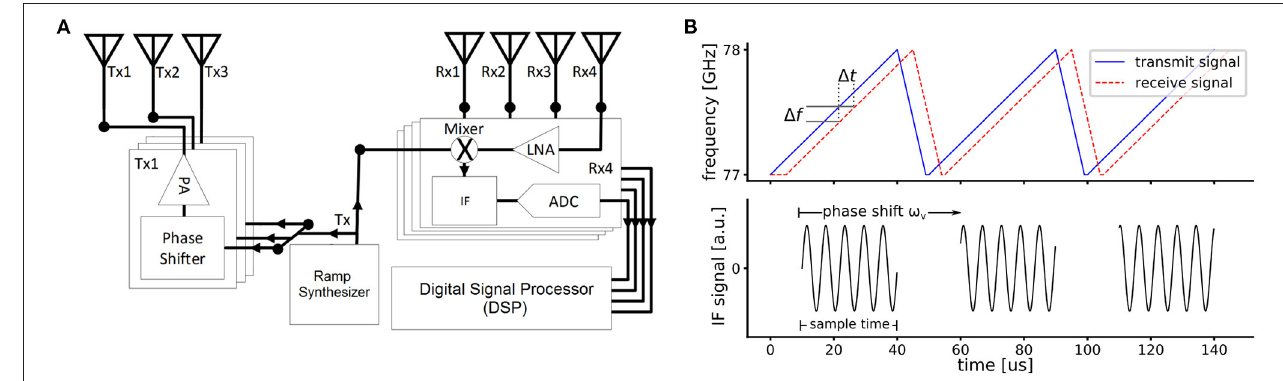
FIGURE 2 | FMCW radar: (A) Schematic of radar frontend with 3 transmitters and 4 receivers. (B) FMCW radar principle showing a sequence of transmitted and received frequency chirps (top) and the sampled IF signal (bottom).